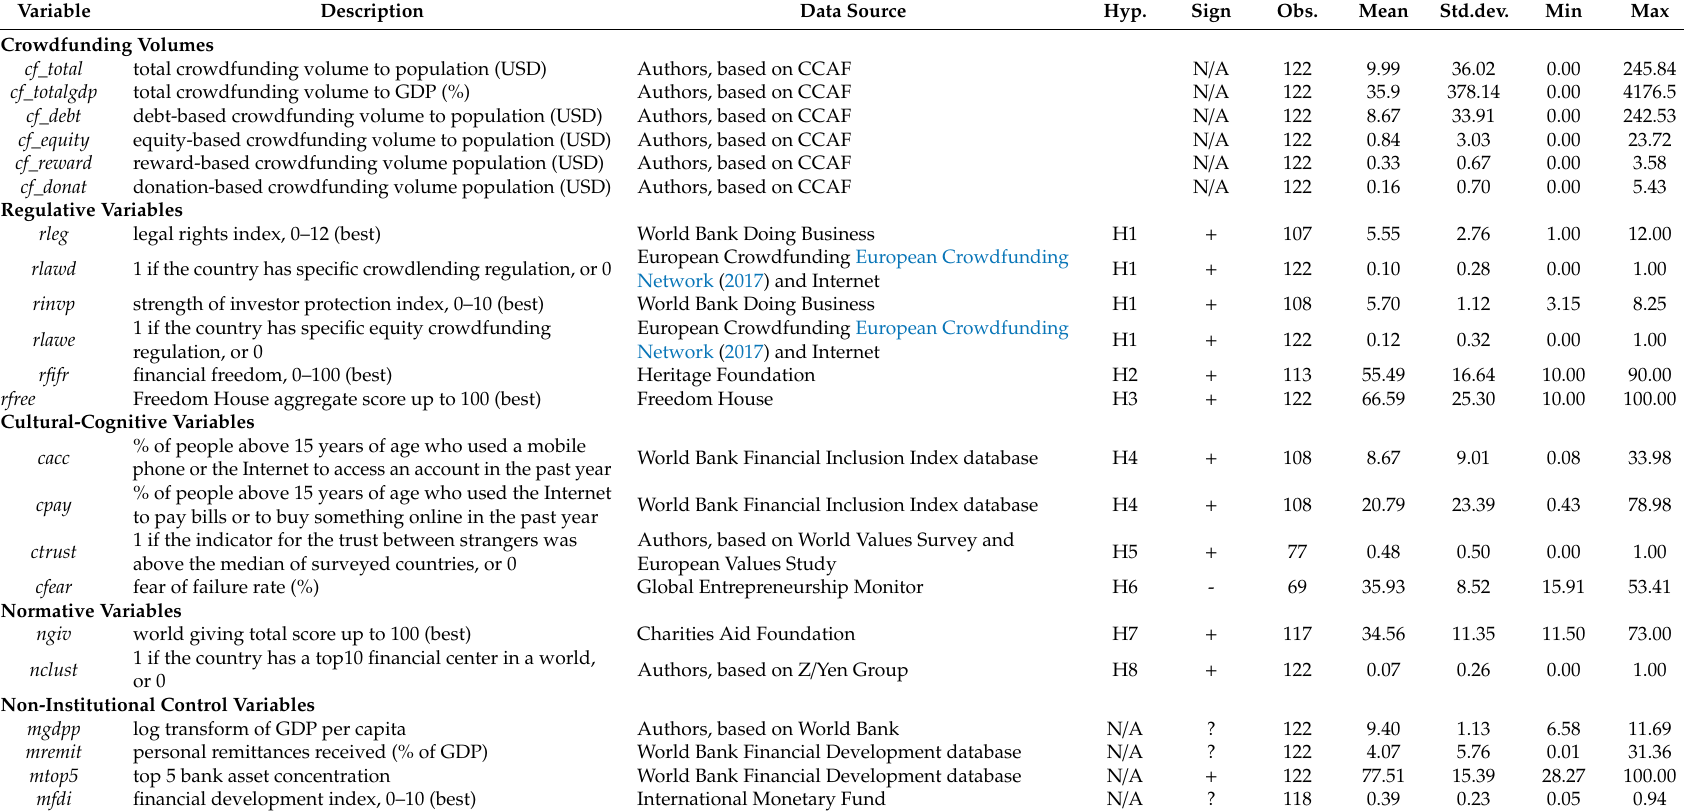
Table 1. Descriptive statistics for